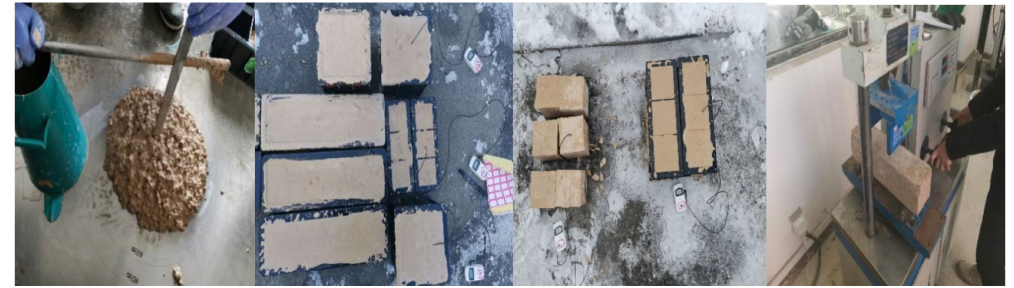
Figure 18. The mixture and specimens of the MPCC.